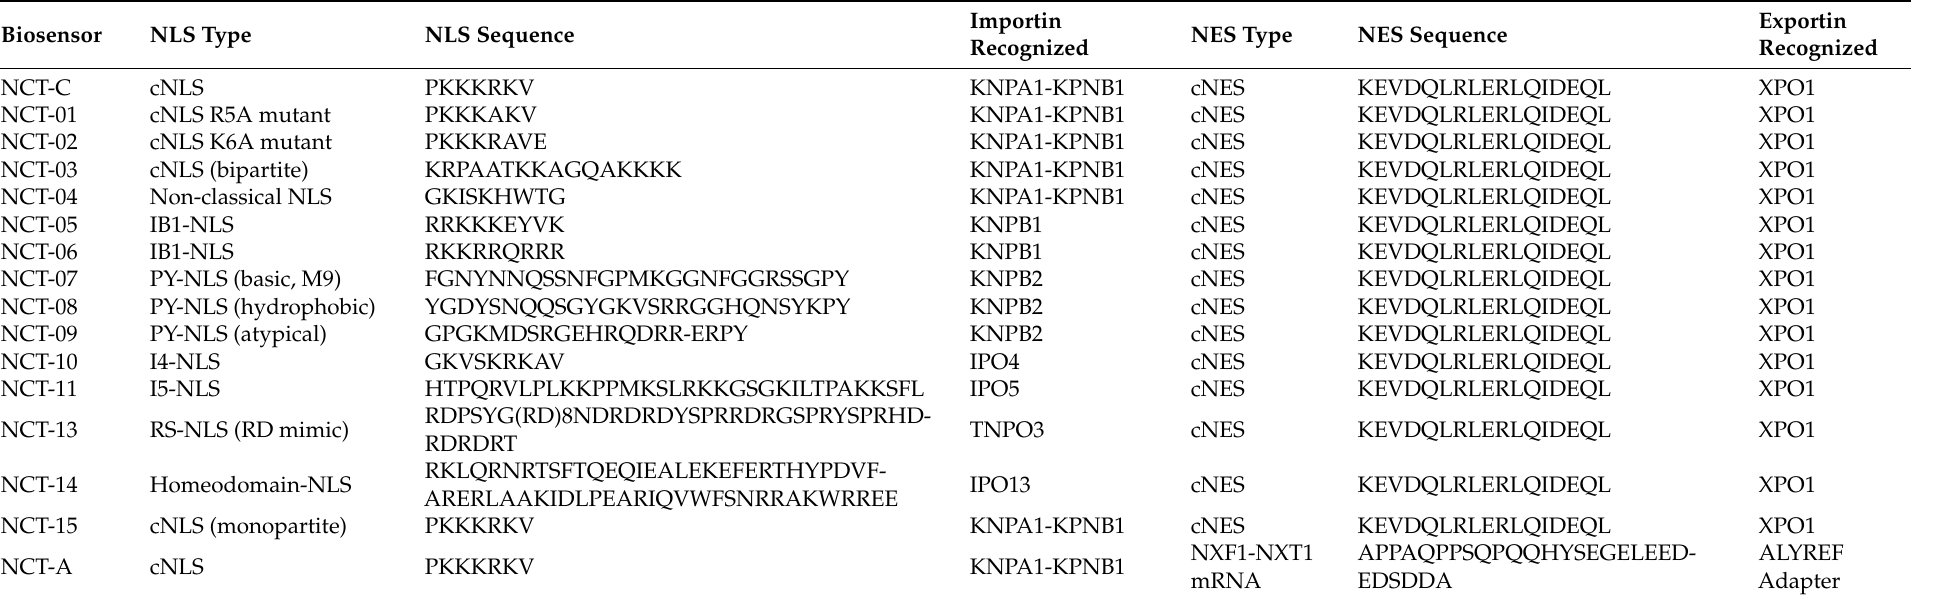
Table 1. NLS and NES classes and sequences of each nucleocytoplasmic transport